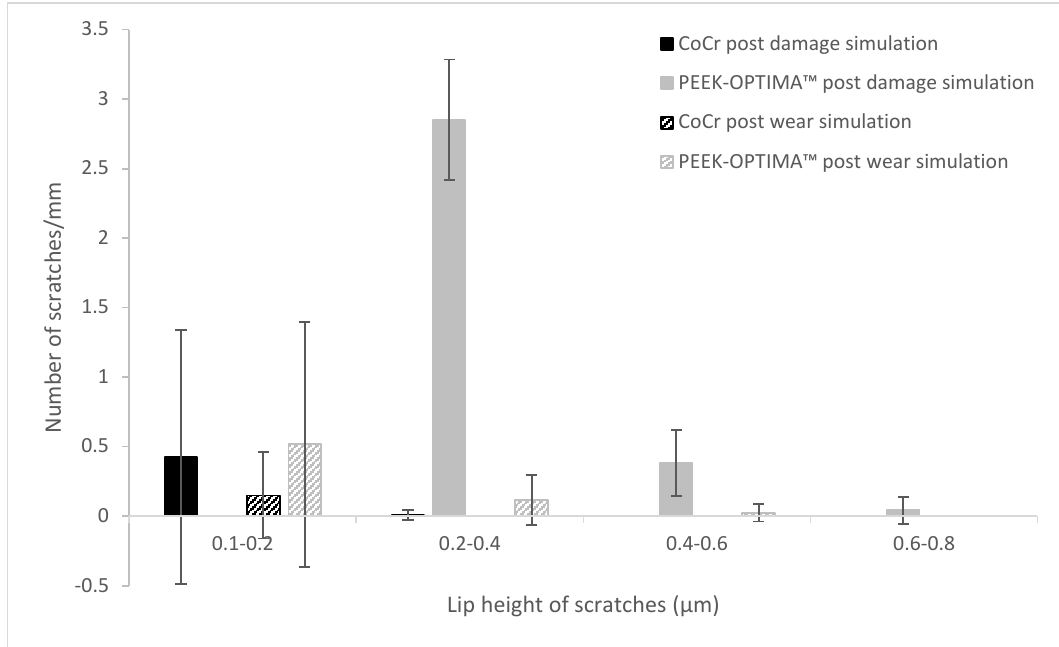
Figure 4. Mean number of scratches per mm ( ± 95 % confidence limits) within given lip height ranges on cobalt chrome and PEEK plates. Measurements taken post damage simulation and post wear test, (n = 3).